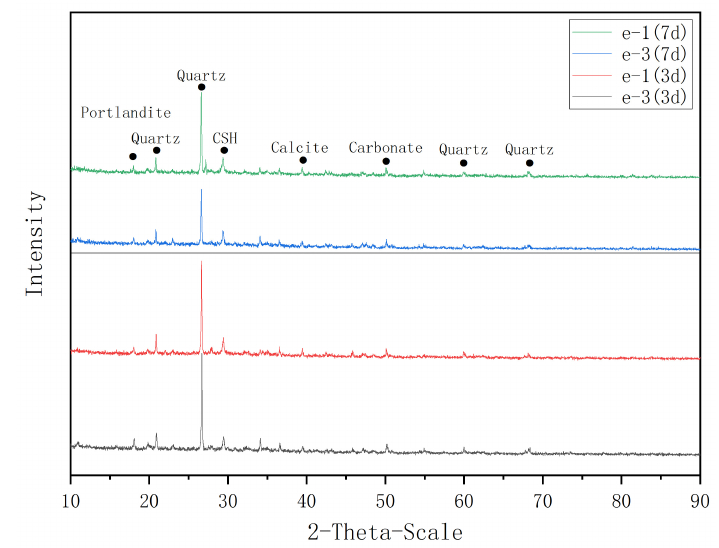
Figure 12. XRD spectra of grout e-1 and e-3 curing for 3 days and 7